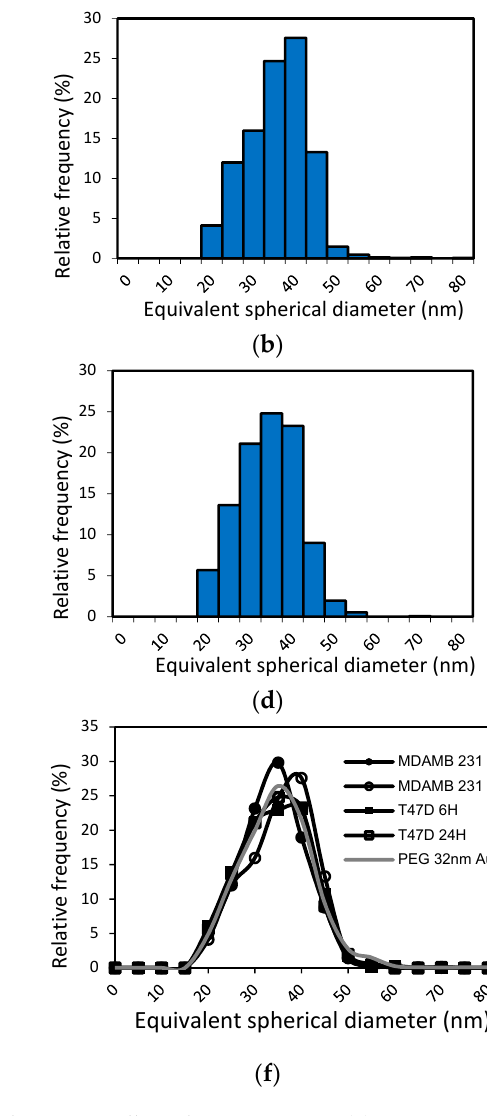
Figure 4. Size distribution of gold nanoparticles in the tumor cells and in suspension: ( a ) MDAMB231 (6 h); ( b ) MDAMB 231 (24 h); ( c ) T47D (6 h); ( d ) T47D (24 h); ( e ) 32 nm PEGylated AuNPs; ( f ) all together.